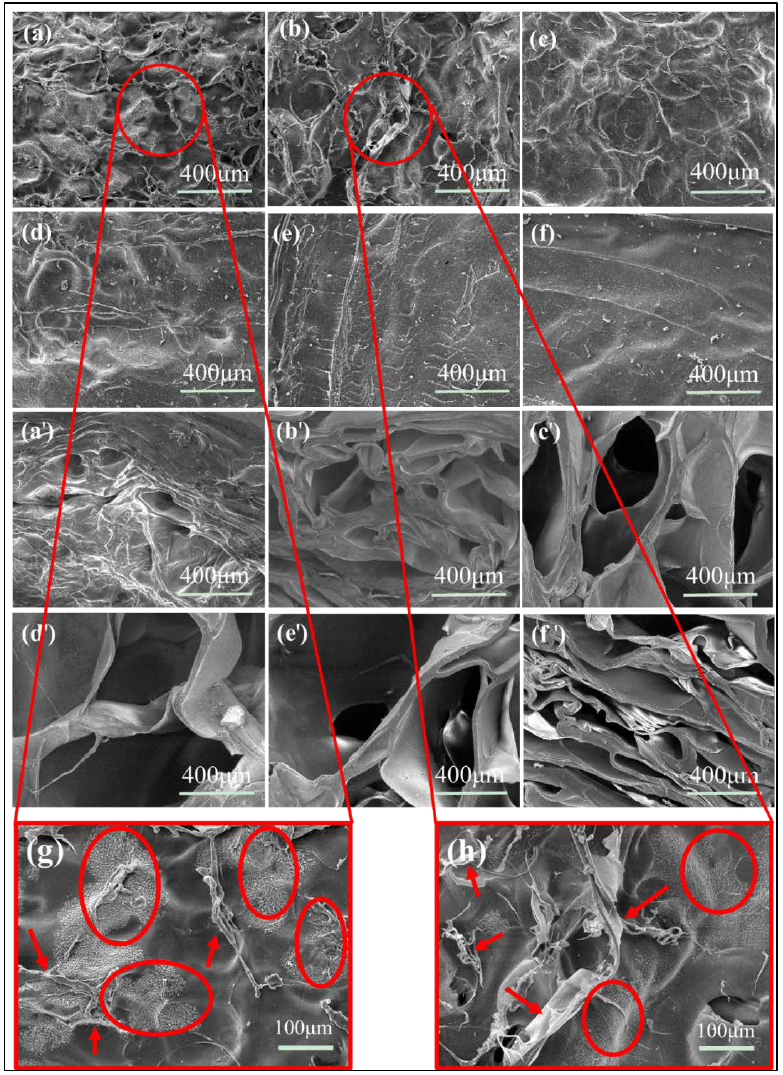
Figure 2. SEM images of SC composite membranes with different mass ratios at surface